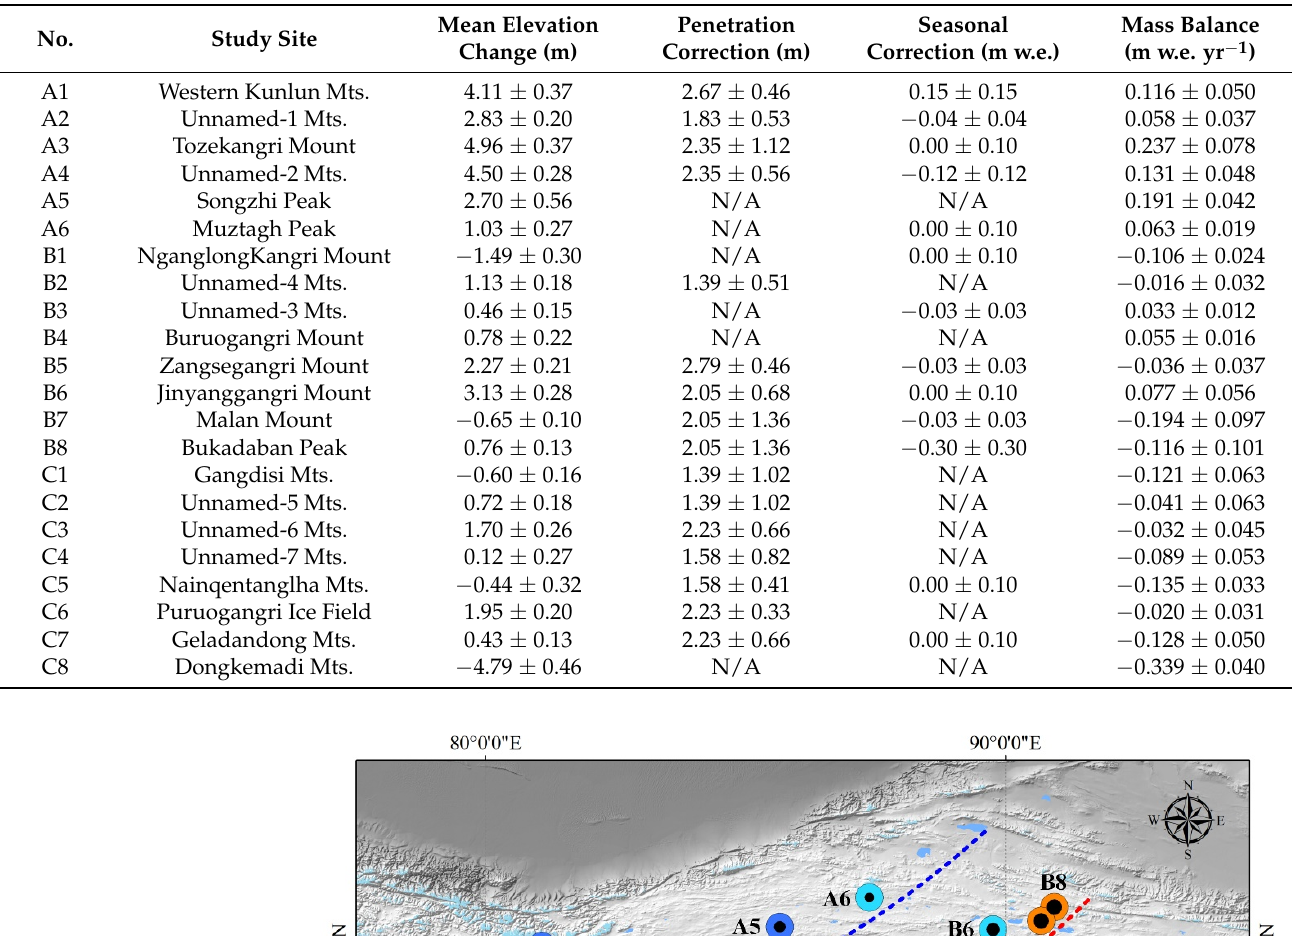
Table 2. The estimated glacier mass changes on the 22 glacierized areas of the INTP between 2000 and 2012. The “N/A” indicates that the corrections of seasonal variations or C/X-band radar penetration differences are not needed for a study site. The number. of each study site is shown in Figure 8.